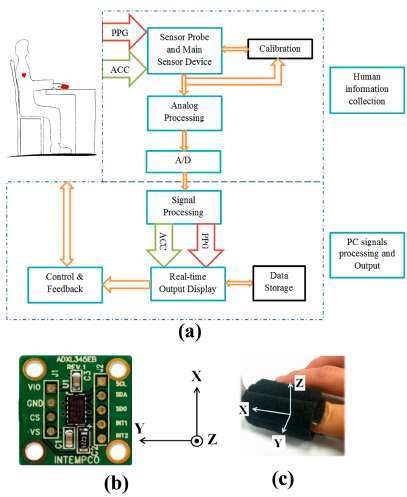
Figure 1. ( a ) Experimental setup of the custom sensor system; ( b ) Accelerometer and ( c ) Finger Clip with axes orientation.